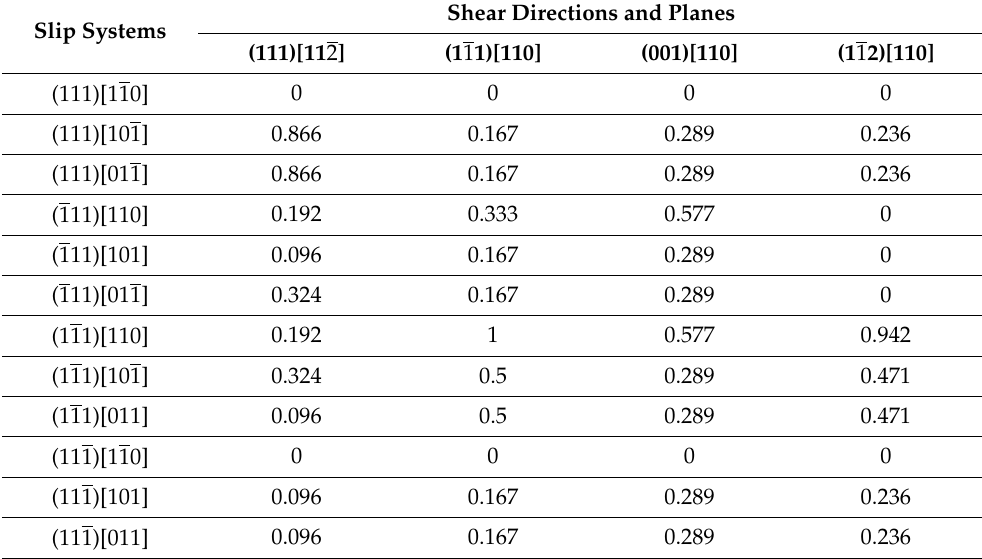
Table 2. The Schmid factors for four shear planes and directions. Slip